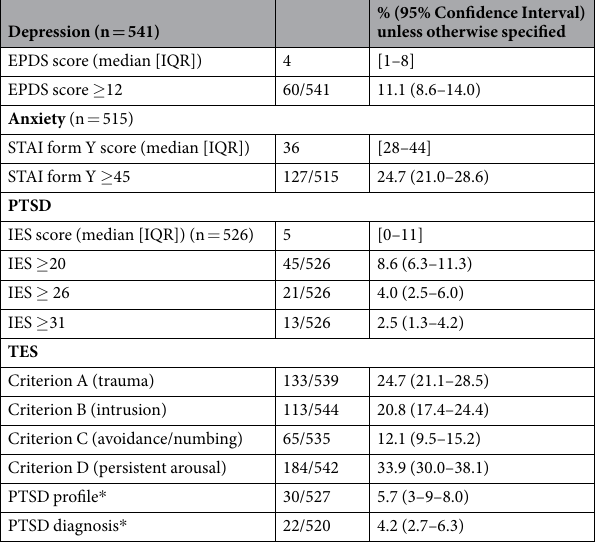
Table 2. Psychological status of respondents one year after a vaginal delivery (n = 549). EPDS, Edinburgh Postnatal Depression Scale; STAI, State-Trait Anxiety Inventory; PTSD, post-traumatic stress disorder; IES, Impact of Event Scale; TES, Traumatic Event Scale. * The term PTSD diagnosis is used when all diagnostic criteria of the DSM-IV (A, B, C, D, E, F) on the TES scale were met. The term PTSD profile is used when all symptom criteria (B, C and D) 1 were met, but some other criteria (A, E or F) were missing 4